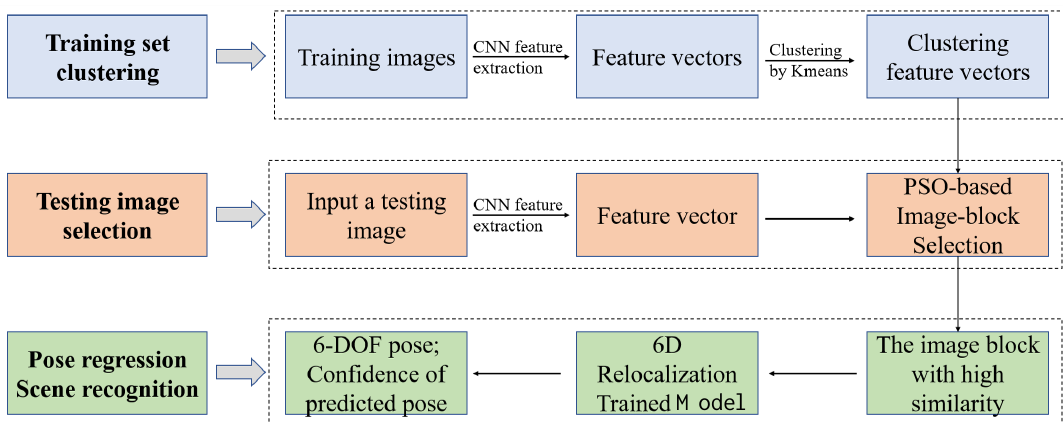
Figure 1. The block-diagram of our methods. The main idea is to crop a testing image into several image blocks, and find the image block with the highest similarity to training set. Firstly, we train our multi-task CNN, thereby obtaining a 6D relocalization trained model. The trained model is used to extract the feature of the image, which forms a feature vector. Secondly, to reduce the computational complexity of image similarity, feature vectors of training images are clustered by k-means. Thirdly, the cropped position of the image, which is regarded as the optimal variable, is optimized by PSO-based image-block selection. Finally, the pose and confidence of predicted pose can be obtained by utilizing 6D relocalization trained model to calculate the selected image block with the highest